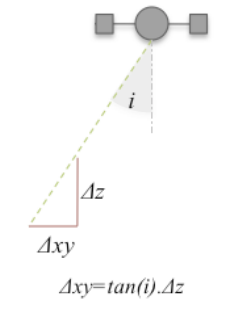
Fig. 6: Error of location according the roll angle